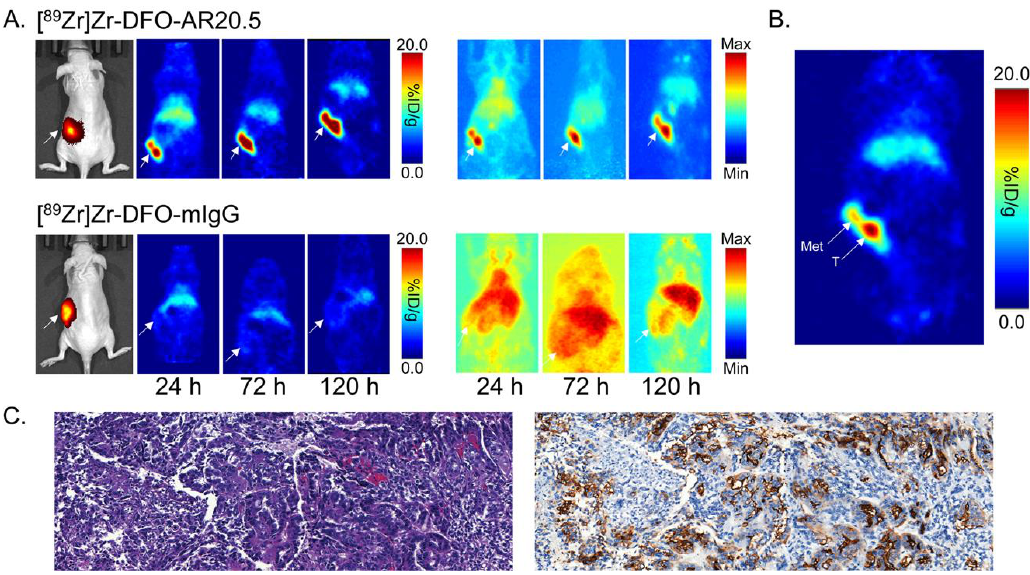
Figure 4. ( A ) Bioluminescence images (left) as well as planar (center) and maximum intensity projection (right; scaled to a minimum of 0% and maximum of 100%) PET images of representative athymic nude mice bearing orthotopic SKOV3-Red-FLuc xenografts obtained 24, 72, and 120 h following the intravenous tail vein injection of [ 89 Zr]Zr-DFO-AR20.5 or [ 89 Zr]Zr-DFO-mIgG. The white arrows mark the tumors; ( B ) Planar PET image of a representative athymic nude mouse bearing an orthotopic SKOV3-Red-FLuc xenograft collected at 120 h post-injection of [ 89 Zr]Zr-DFO-AR20.5. The white arrows mark the tumor (T) and a peritoneal metastatic lesion (Met); ( C ) Hematoxylin and eosin staining (10 × magnified; left) and immunohistochemical staining (10 × magnified; right) of the peritoneal metastatic lesion from the representative mouse, with brown staining indicating the expression of MUC1.